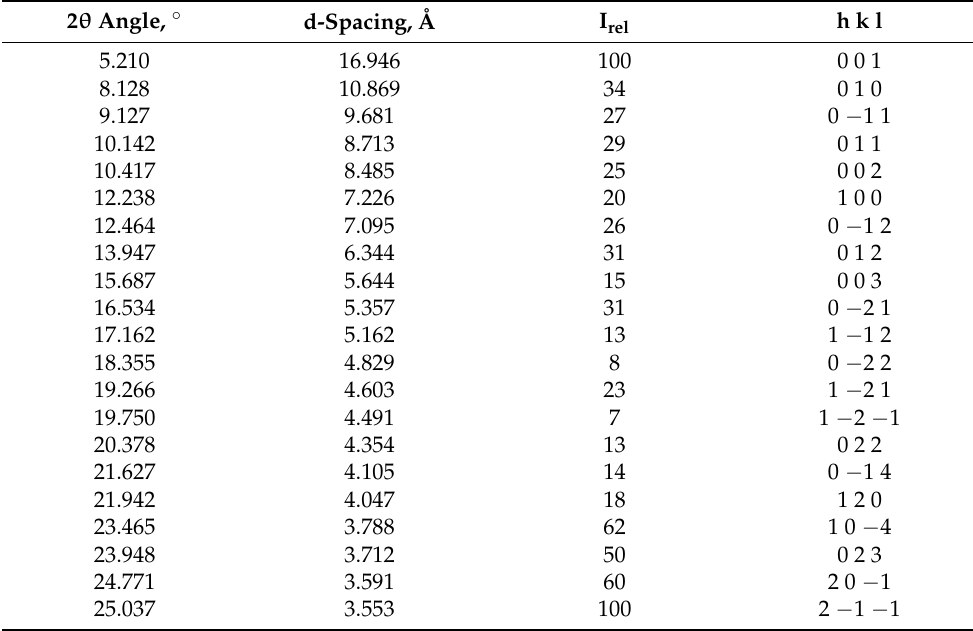
Table 10. List of observed 2 θ angles, d-spacings, and relative intensities, jointly with reflection indices, for Eltrombopag Form V.